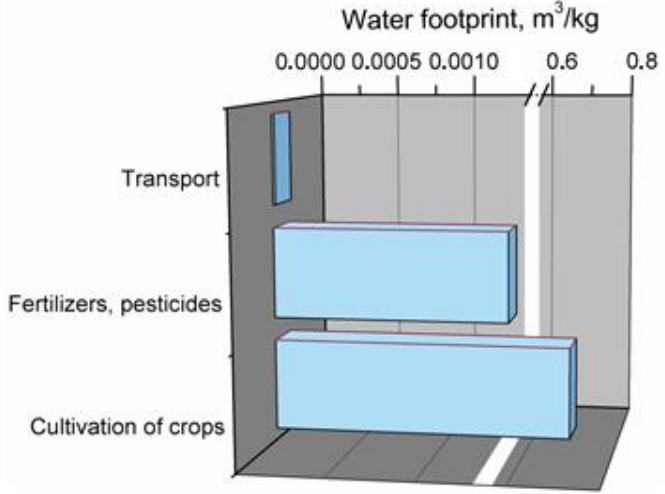
Figure 10. Main components of production system generating water footprint of kenaf fibers.